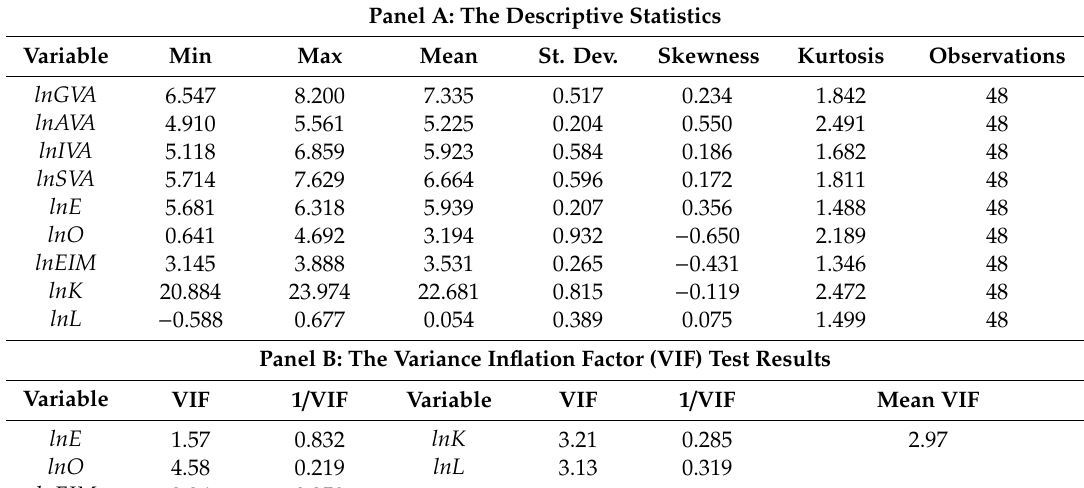
Table 2. The descriptive statistics and variance inflation factor analysis. Panel A: The Descriptive Statistics